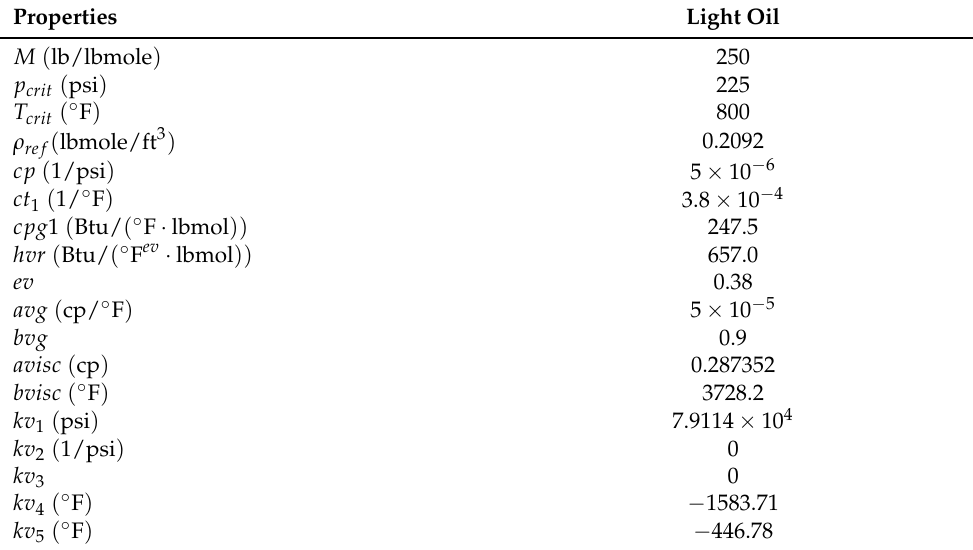
Table 6. Light oil property data for Example 2.